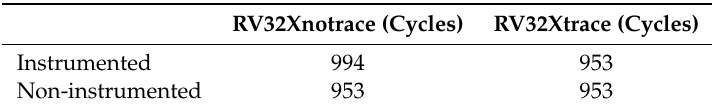
Table 3. Number of execution cycles of both instrumented and non-instrumented RVS tutorial test on both RV32Xnotrace and